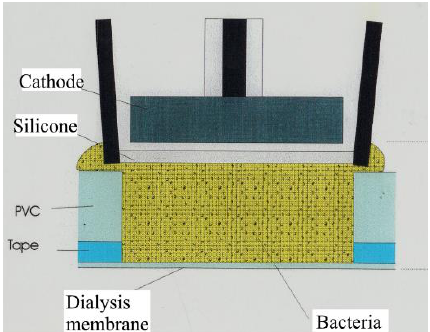
Figure 2. Design of a macroscale biosensor where the bacteria are housed in a 0.3–0.5 mm diameter hole drilled in a PVC or PET plate. (Original image from authors). Sensors 2020 , 20 , x FOR PEER REVIEW